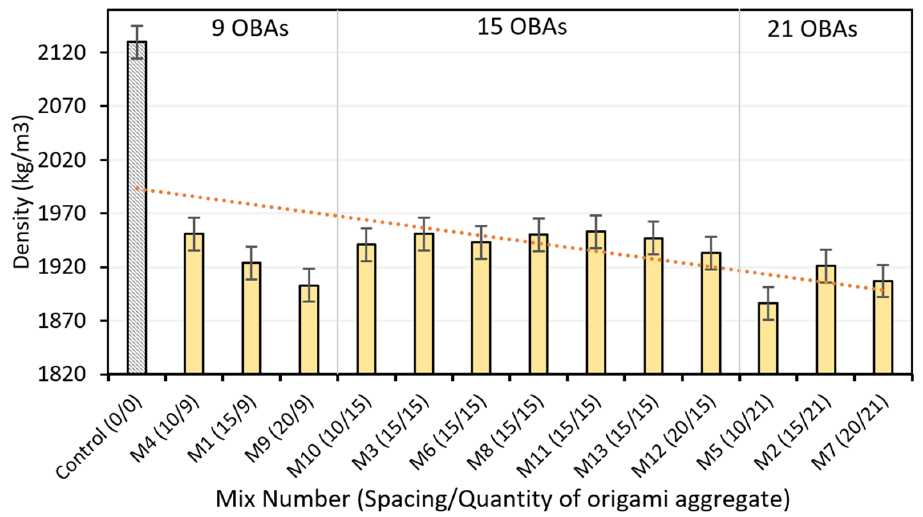
Figure 6. The density of OBA ‐ RECC mixes.